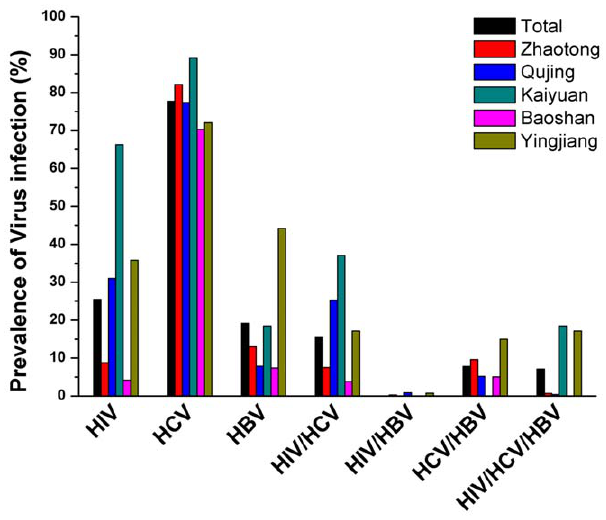
Figure 1. Prevalence of HIV, HCV, HBV infection and co- infection among 5 study